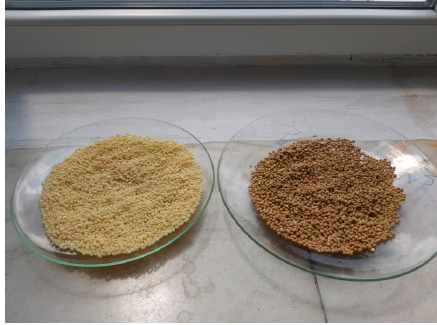
Figure 3. NPK granules before and after